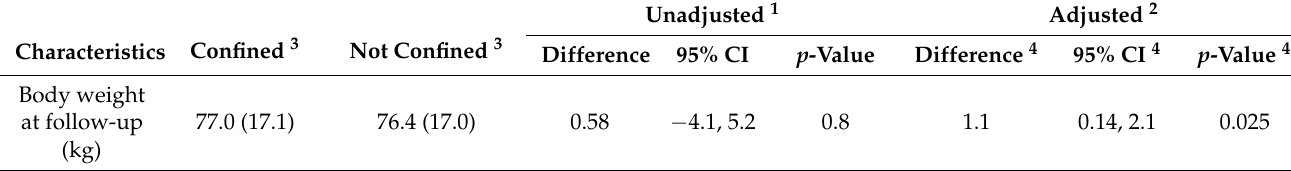
Figure 2: more time spent in lockdown was associated with slightly higher BES scores and slightly lower rMEQ scores ( p = 0.027 and p = 0.038, respectively). Table 3. Differences of body weight at follow-up between confined and non-confined groups both unadjusted and adjusted for baseline measurement of the outcome and for baseline measurement of the outcome and all matching variables (age, sex, baseline body weight, body height, baseline body fat mass, total daily energy intake prescribed, baseline weekly METs, time to follow-up examination).